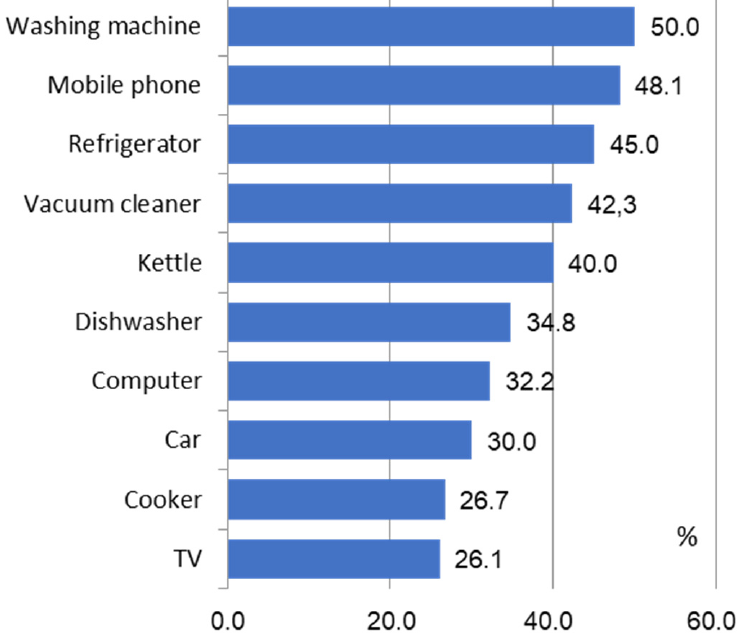
Figure 1. Percentage of buyers of selected durable goods who strongly agreed with the statement that producers deliberately age products so that customers buy more often.